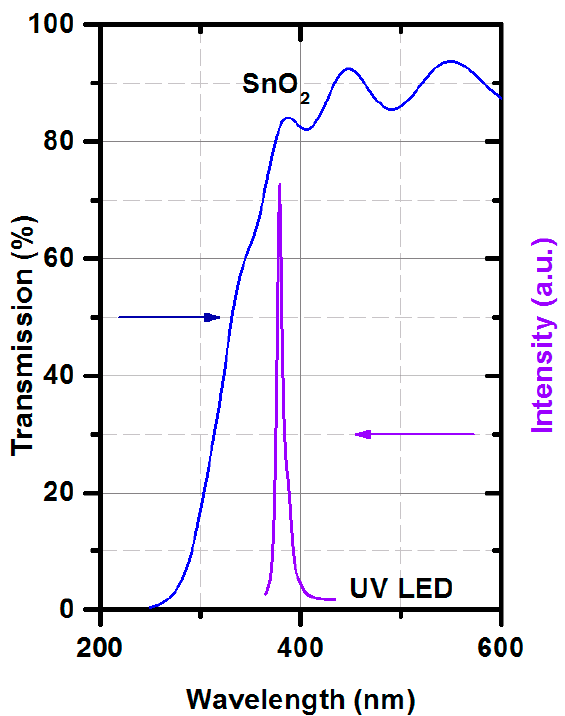
Figure 2. The SnO 2 transmission with the intensity of the UV LED diode ( OSV2YL5111A) in the function of wavelength.